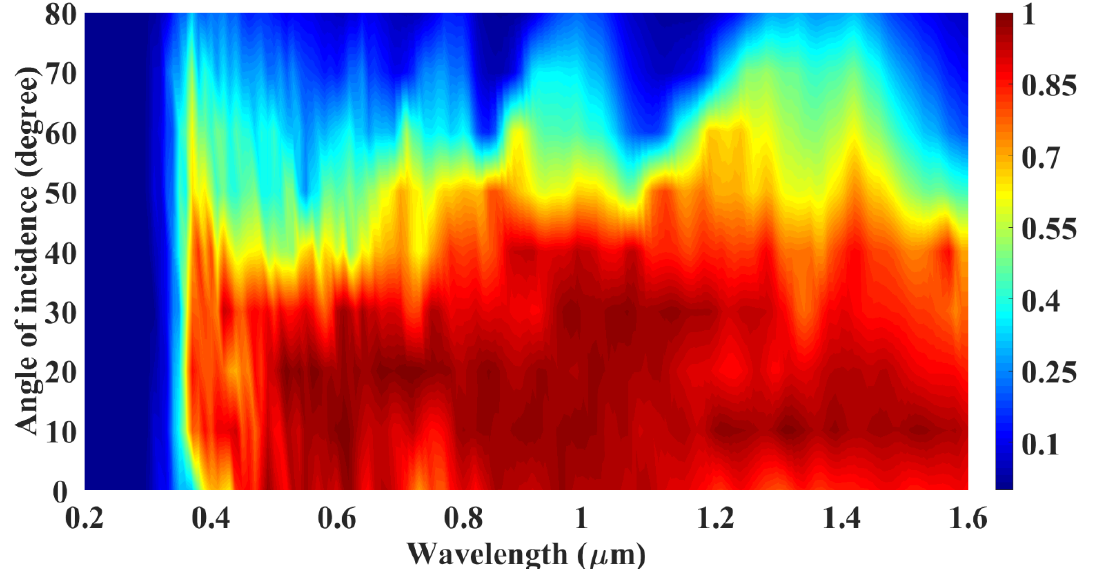
Figure 6. The angle of incidence variation absorption results. The wavelength spectrum of 0.2 to 1.6 micrometers. The angle of incidence is varied from 0 to 80°. A wide angle of incidence of 0 to 50° is available for this T-shape metasurface solar absorber design.